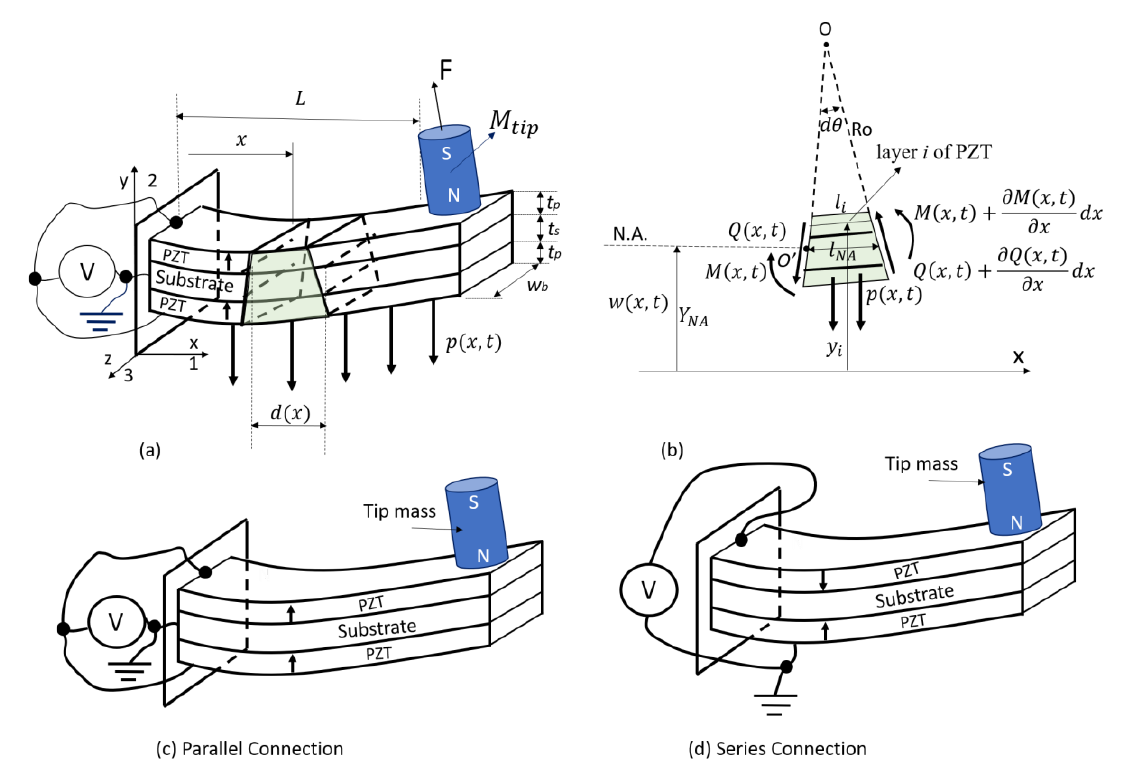
Figure 2. ( a ) A cantilever triple-layer piezoelectric harvester in transverse vibration. ( b ) Free-body diagram of a small element. ( c ) Parallel connection. ( d ) Series connection.